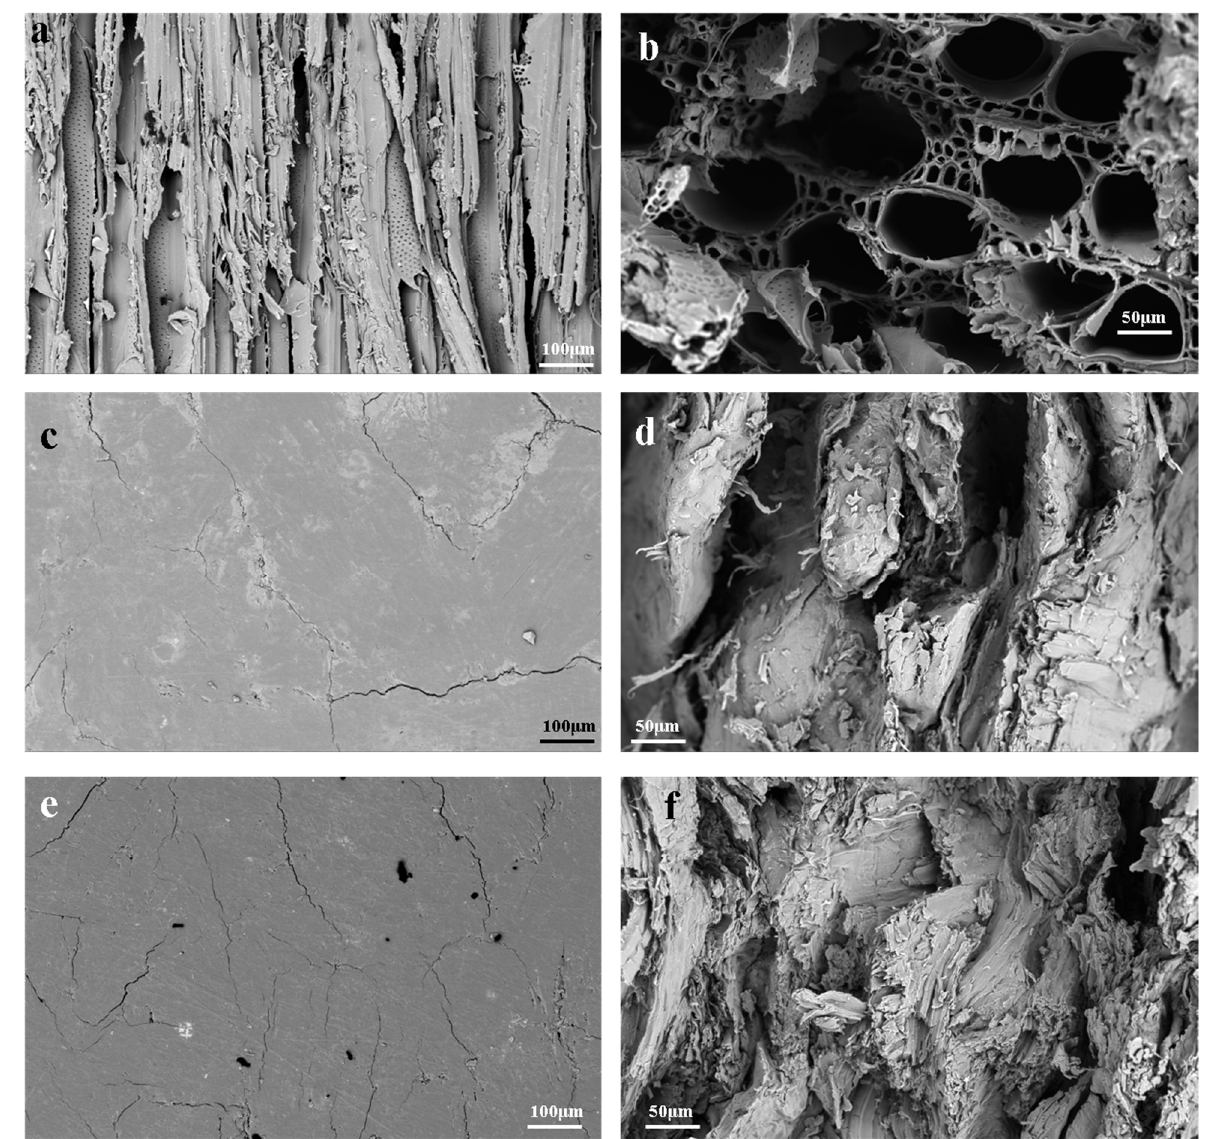
Figure 5. ( a ) Poplar surface viewed at a microscopic scale. ( b ) Cross-sections of poplar microscopic images. ( c ) WF surface viewed at a microscopic scale. ( d ) Cross-sections of WF microscopic images. ( e ) WF(PA/B) surface viewed at a microscopic scale. ( f ) Cross-sections of WF(PA/B) microscopic images.